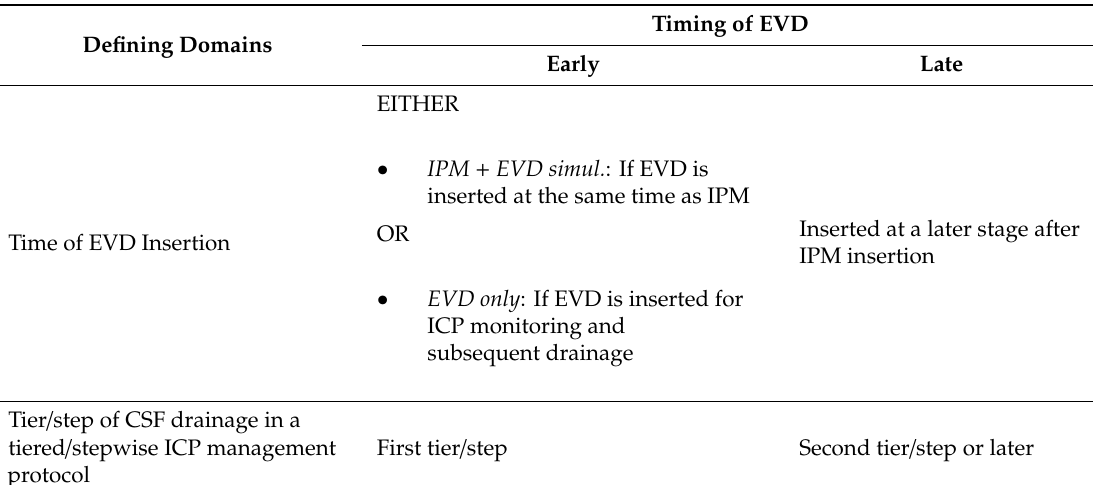
Table 1. Definition of the timing of EVD (early vs.